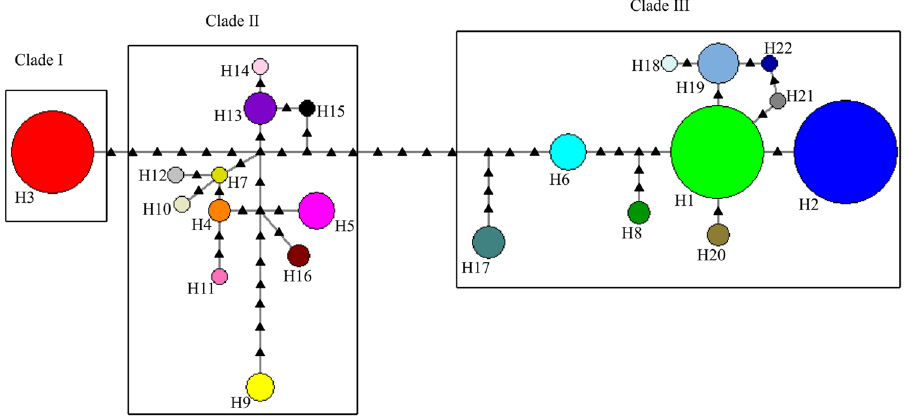
Figure 4. Median joining network of haplotypes of tea based on cpDNA sequence data. The size of the circles corresponds to the frequency of each haplotype whereas the small black triangles represent mutational